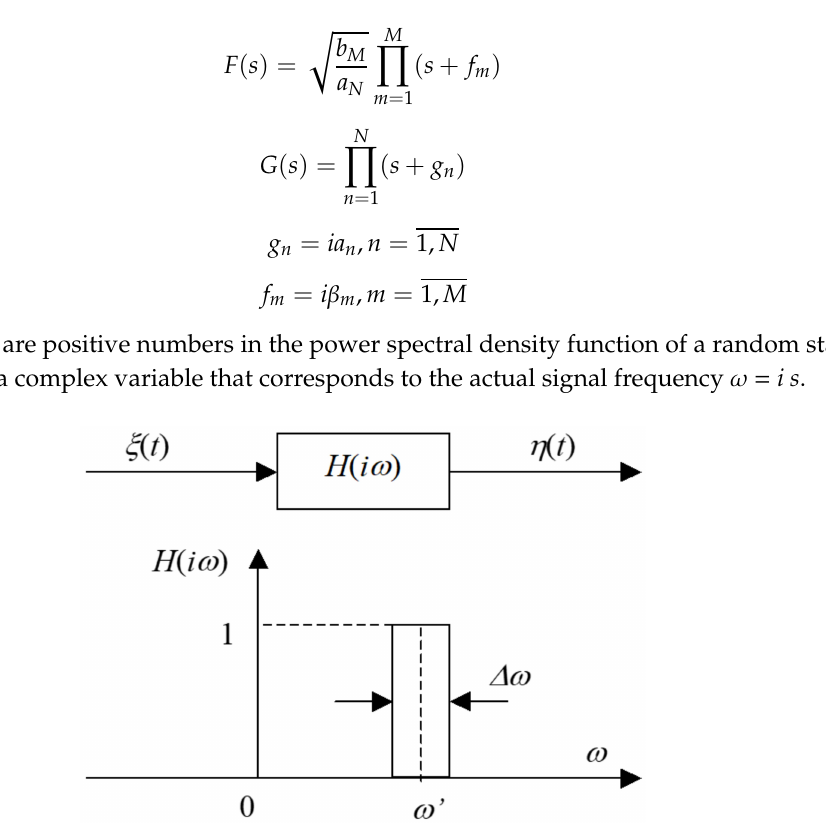
Figure 1. Functions of the power spectral density of a linear